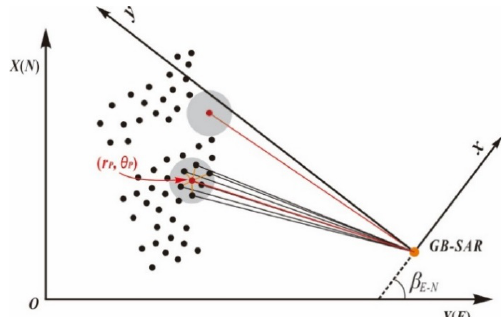
Figure 2. Coordinate polarization of point cloud and matching with GB-SAR pixel.